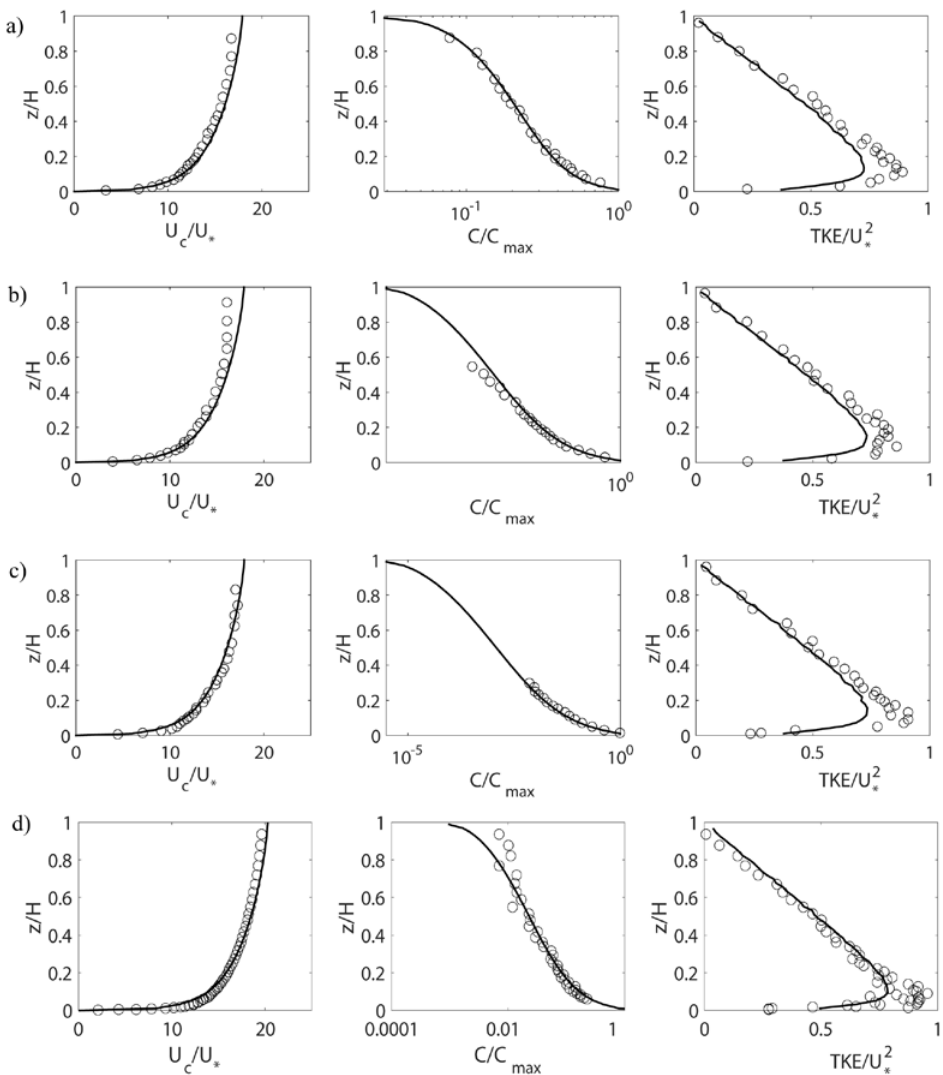
Figure 5. Comparison of numerical results of carrier velocity, sediment concentration and total kinetic energy (TKE) for tests by [93]: ( a ) PS03; ( b ) PS08; ( c ) PS13; and a test by [48]: ( d ) NS1. Adapted from [43]. The circles represent the experimental data, and the solid line represents the numerical result.